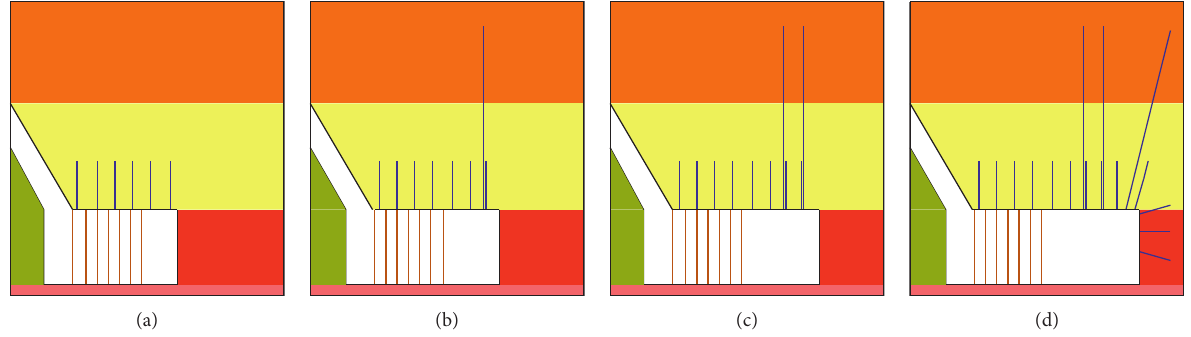
Figure 8: Simulation process of removal area. (a) First cutting. (b) Second cutting. (c) Third cutting. (d) Fourth